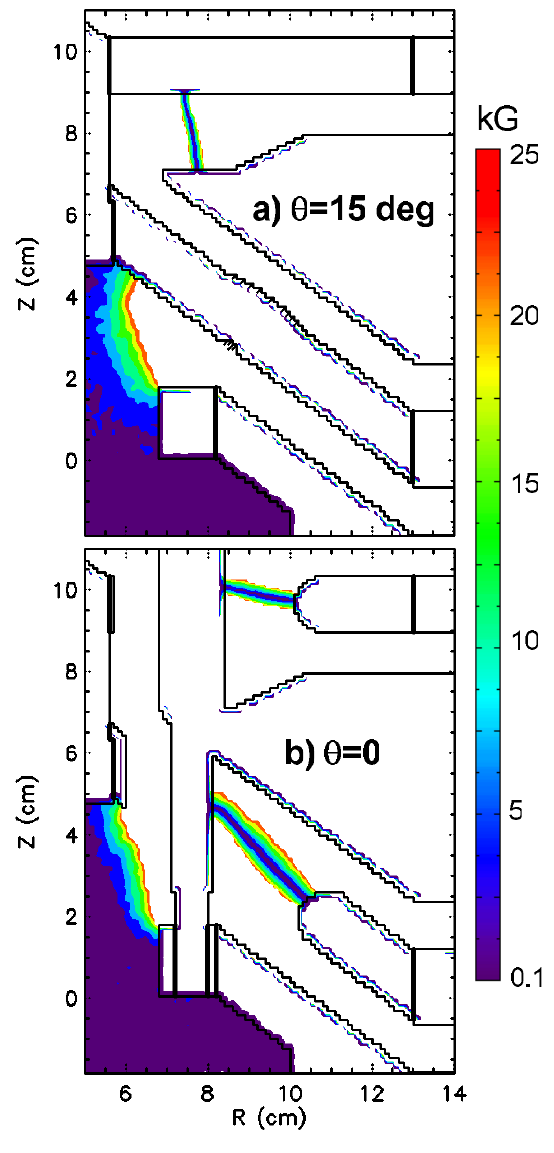
FIG. 5. (Color) Magnetic field magnitude in the (a) (cid:1) (cid:4) 15 degree and (b) (cid:1) (cid:4) 0 planes illustrating the location of the magnetic field